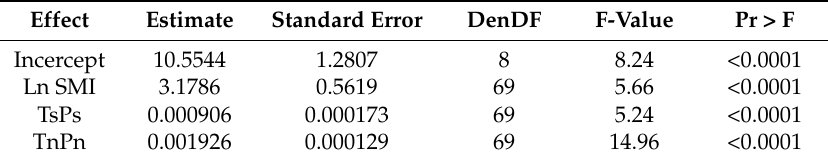
Table 4. Solution and Type 3 tests for fixed effects in the mixed model.